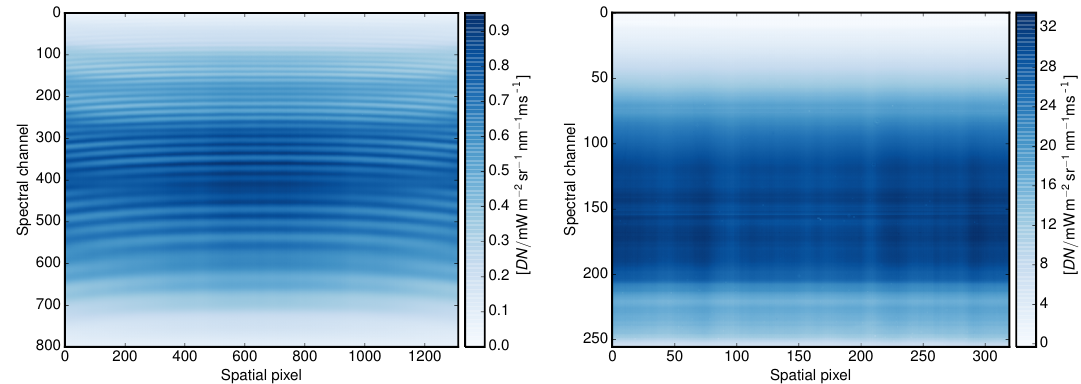
Figure 11. Absolute radiometric response R in [ DNms − 1 mW − 1 m 2 nmsr ] for the VNIR (left) and SWIR (right) spectrometer. The radio- metric response shows a strong dependence with wavelength for both sensors, which is expected due to a material-dependent band gap and the specific transmissivity of the optical system. The VNIR sensor shows an etalon fringe pattern typical of backside-illuminated sensors.